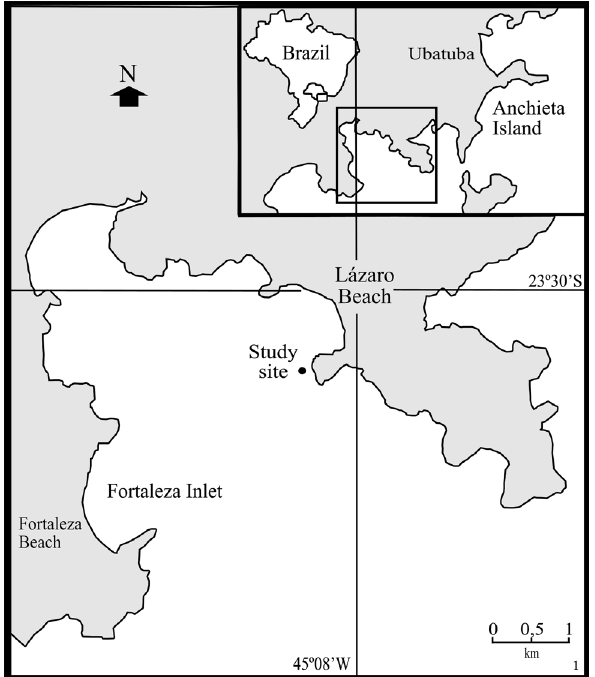
Figure 1. Map of the studied region indicating sampling site.